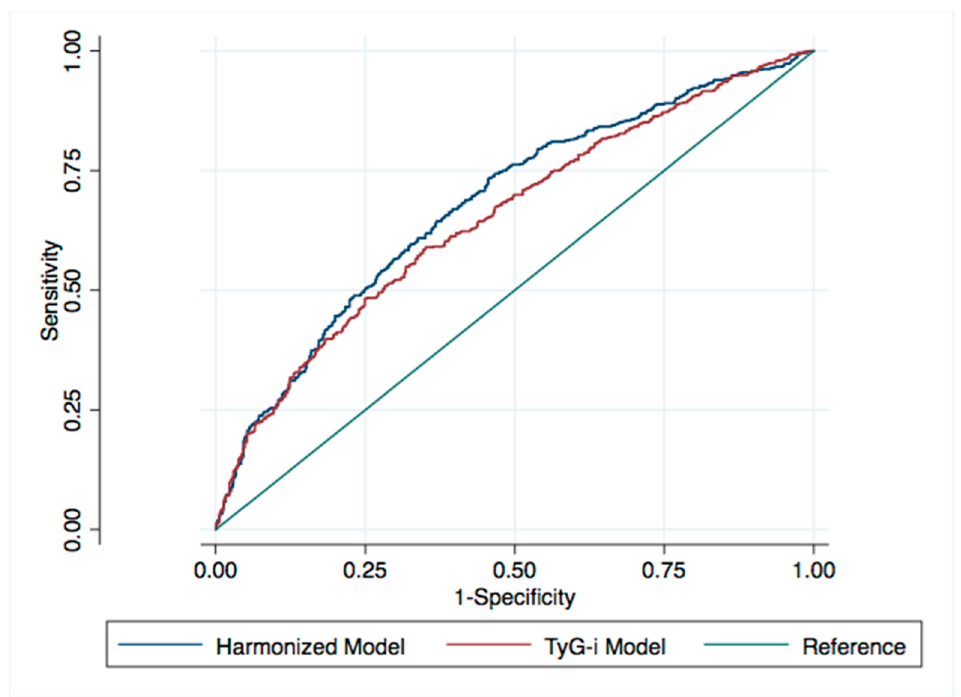
Figure 2. ROC curve comparison for final models in normoweight young adults. Both models are adjusted for sex, age, baseline BMI, TC, alcohol consumption, fatty food consumption, vegetable and fruit consumption, smoking habit, exercise, and family disease history.